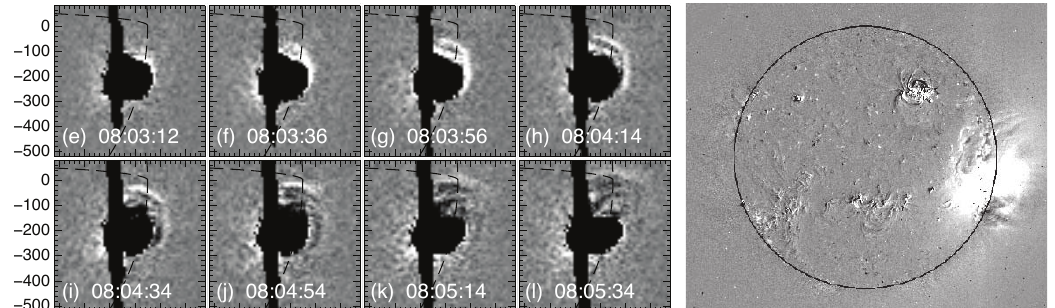
Figure 18: The refracting coronal wave of 1998 May 6. Left : Running difference images in soft X-rays by Yohkoh/SXT showing the propagation of the coronal wave to the north along the solar limb. The black region is an artifact due to overexposure from the flare. Note that the nearly circular wavefronts tilt increasingly forwards toward the solar surface. Right : EIT 195 ˚A difference image showing a rippled EIT wavefront that shows the same downward tilt as the SXT wave. Images reproduced with permission from Hudson et al. (2003), copyright by